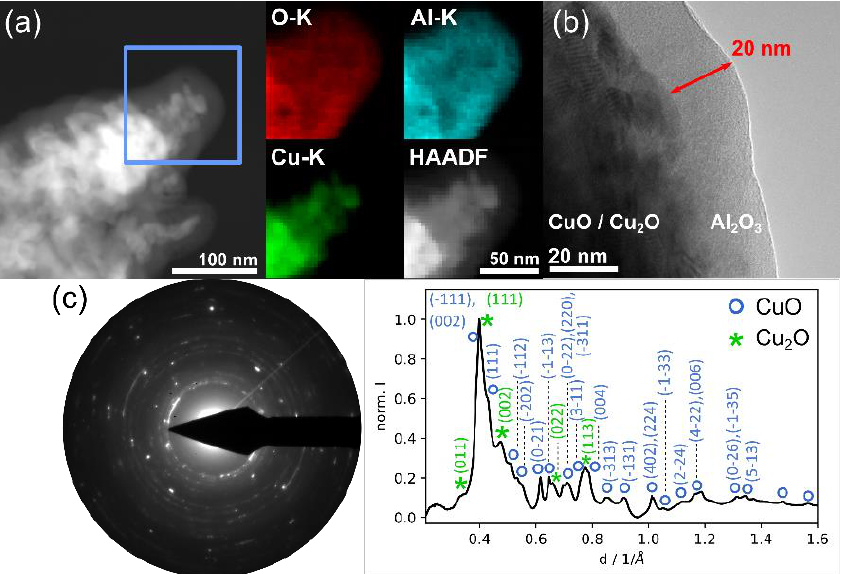
Figure 5. ( a ) HAADF-STEM micrograph of a top-edge region of a CuO particle with a clearly visible outer layer also confirmed by STEM EDX maps of the marked region; ( b ) HRTEM micrograph of the Al 2 O 3 /Cu 2 O/CuO structure revealing a homogenous outer layer with a thickness of 20 nm; ( c ) SAED pattern of a larger sample area containing the region shown in ( a ) and its rotational average of the diffracted intensity. The reflections of monoclinic CuO and cubic Cu 2 O are marked. (SAED), patterns are taken from a larger sample area including the area shown in Figure